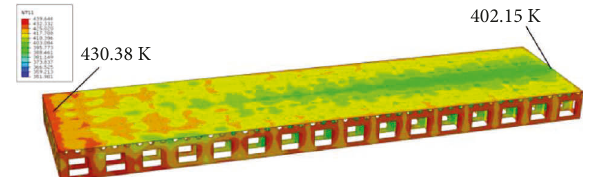
Figure 5: Temperature nephogram of the tool at the end of the heating up.